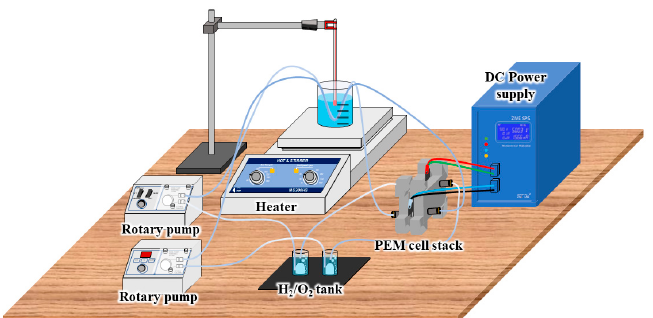
Figure 4. Schematic diagram of experimental apparatus for PEM water electrolyzer cell experiments [17].